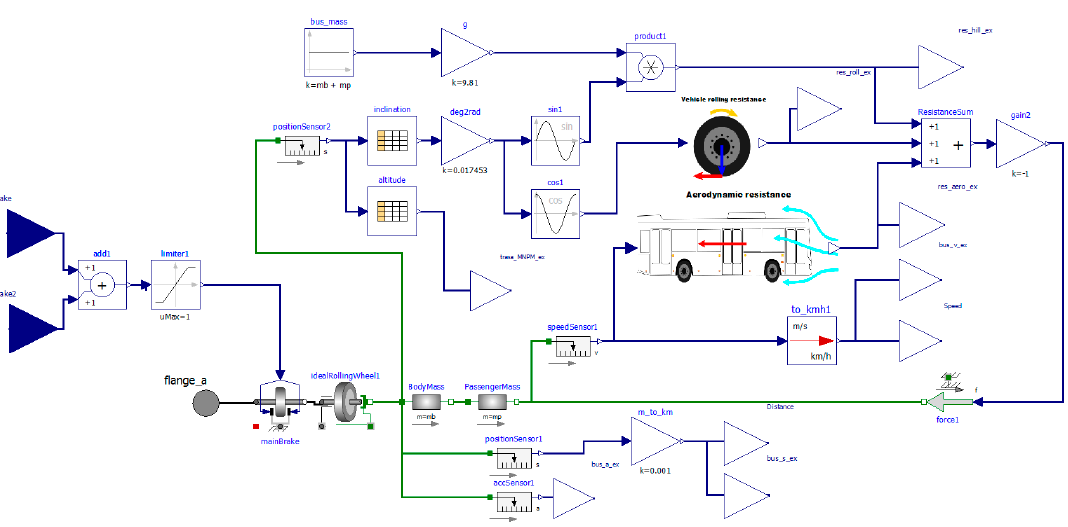
Figure 6. Modeling of forces acting on the electric bus.